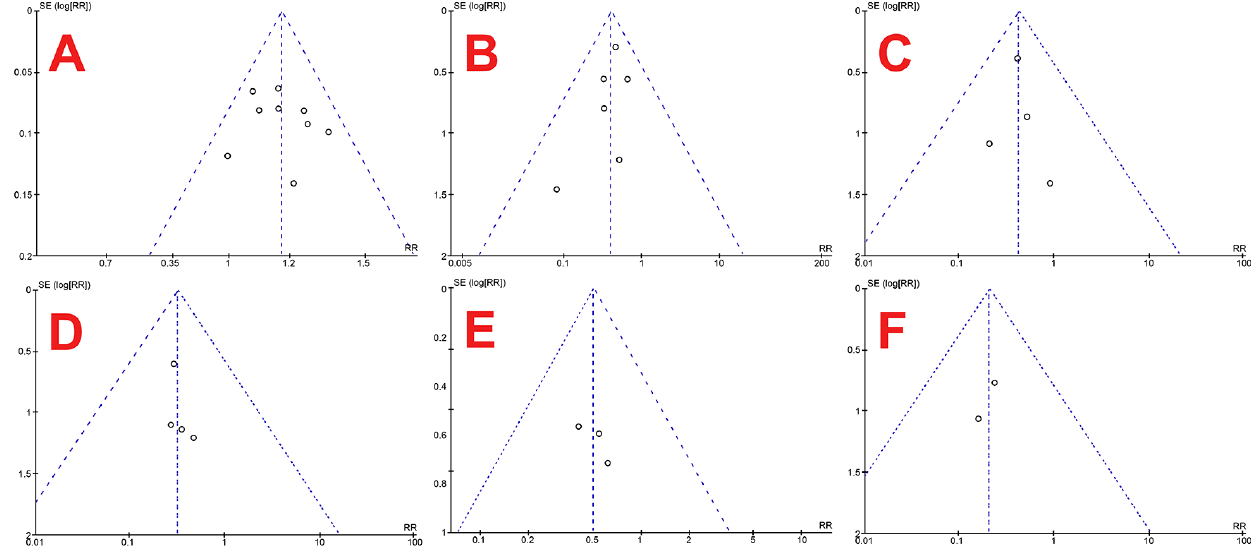
Figure 5. Funnel plots of stone-free rate ( A ), overall complication rate ( B ), hematuria ( C ), mucosal injury ( D ), readmission rate ( E ) and colic episodes ( F ). Aside from the strengths, this systematic review and meta-analysis has a limitation. This study’s limitation is that there were only eight studies eligible for review, and there were only two studies for each outcome, which makes its representability somewhat questionable.